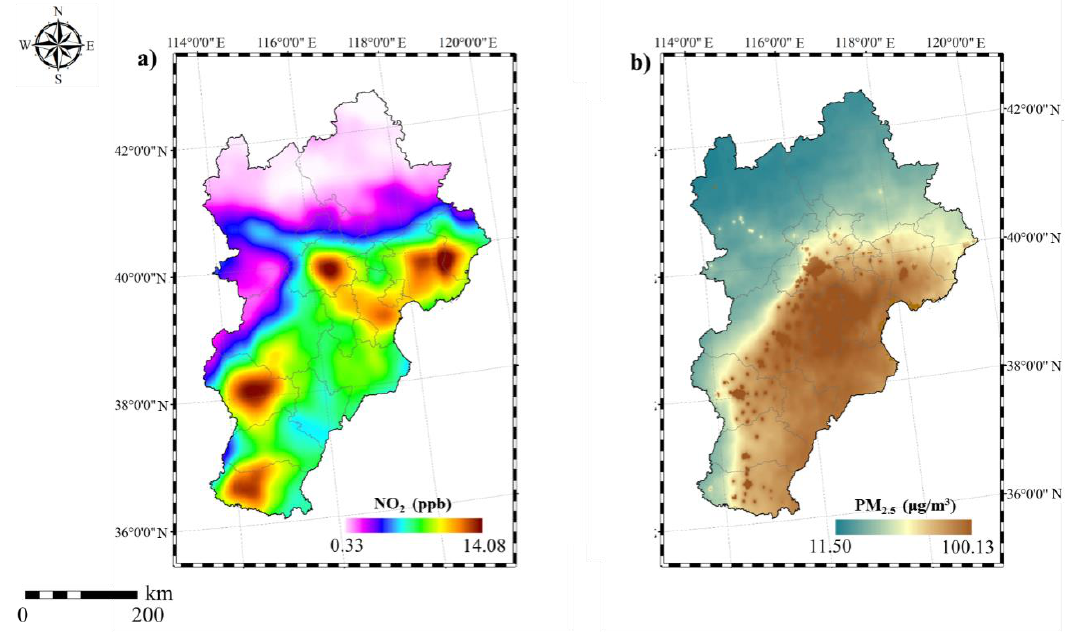
Figure 3. Spatial pattern of PM 2.5 ( a ) and NO 2 ( b ) concentrations in 2015 for the Beijing-Tianjin-Hebei region.